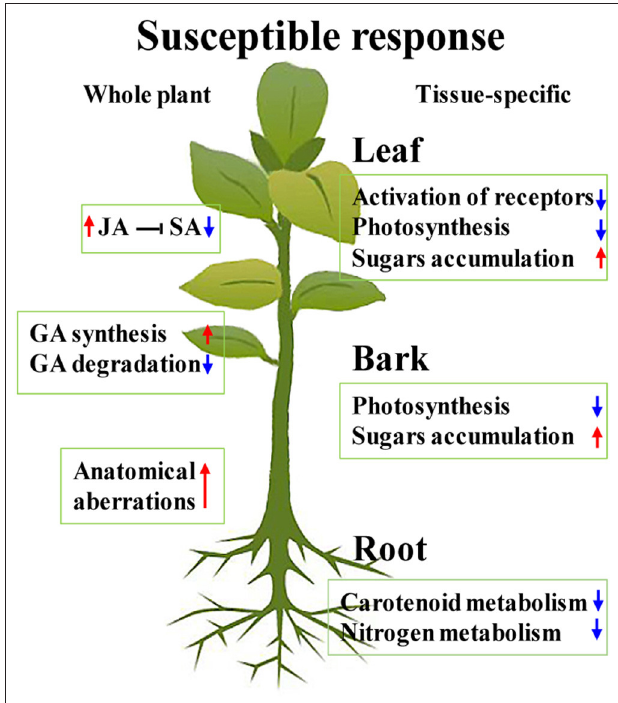
FIGURE 9 | Hypothesized model for the whole plant and tissue-specific HLB susceptible response of Chongyi. Red arrows indicate induction, and blue ones indicate